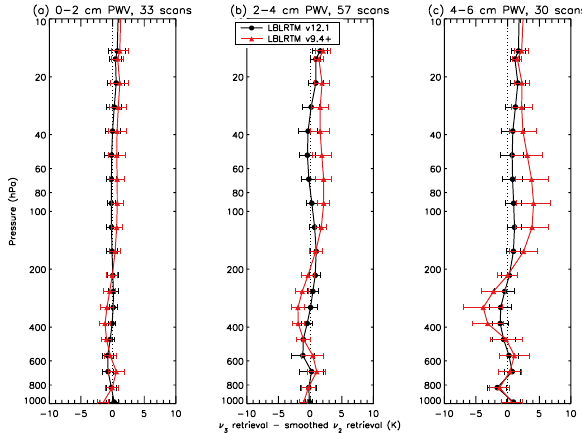
Fig. 13. As in Fig. 10b, but only for profiles with (a) 0 to 2cm, (b) 2 to 4cm, and (c) 4 to 6cm of